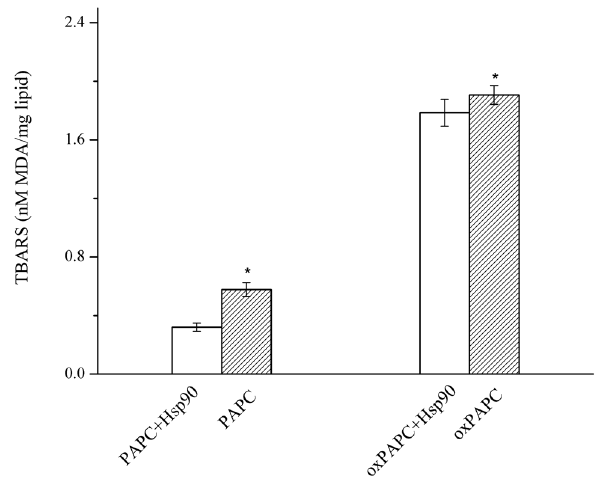
Figure 3. Effect of Hsp90 added to PAPC and oxidized PAPC lipos- omes on formation of MDA. Lipid alone had significantly higher MDA levels than the lipid added with Hsp90 (p<0.05). Hsp90, 90 Kda heat shock protein; PAPC, L-a-1-palmitoyl-2-arachidonoyl-sn-glycero-3-phos- phorylcholine; MDA, malonaldehyde; oxPAPC, oxidized PAPC. Bars indicate standard deviation. * Indicates significant difference between lipid alone (PAPC or oxPAPC) and lipid added with Hsp90 (PAPC+ Hsp90 or oxPAPC+Hsp90)